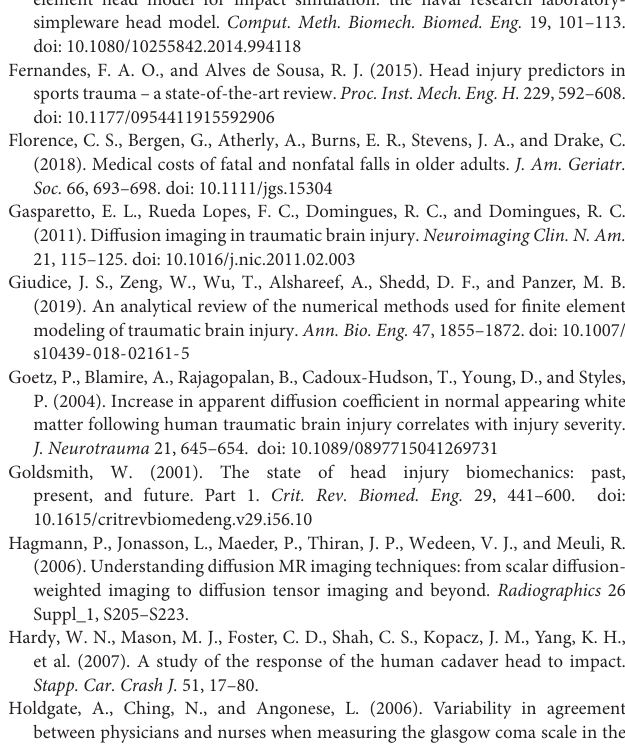
Supplementary Figure 1 | Case 1 of skull indentation: medical images (FLAIR, CSF in dark) on axial/transverse planes. Supplementary Figure 2 | Case 2 of coup-contrecoup injury: medical images (FLAIR, CSF in dark) on axial/transverse planes. Supplementary Figure 3 | Contours of different strain rate measures showing similar patterns but with different magnitudes. Supplementary Figure 4 | Correspondence between ADC values and maximum effective strain rate at coup location in transverse plane of case 1. Values are plotted along horizontal line through the coup between points C and A. 1, 2, and 3 mark the location filled with fluid, C stands for coup region. The dotted line represents approximate mean ADC value of brain tissue. Supplementary Figure 5 | Correspondence between ADC values and minimum pressure at showing coup location in transverse plane at the coup of case 2. Values are plotted along for the line through the contrecoup between points A and CC. 1, 2, and 3 mark the location filled with fluid, CC stands for contrecoup regions. The dotted line represents approximate mean ADC value of brain tissue. Supplementary Table 1 | Comparison of heads of case 1 and case 2 with computational head